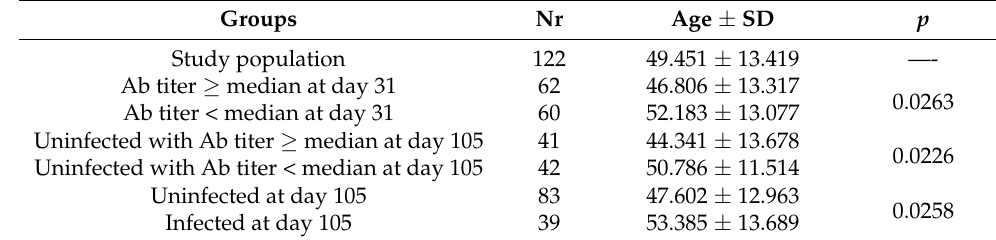
Table 3. Analysis of the significant differences in age distribution between different groups and subgroups of subjects.